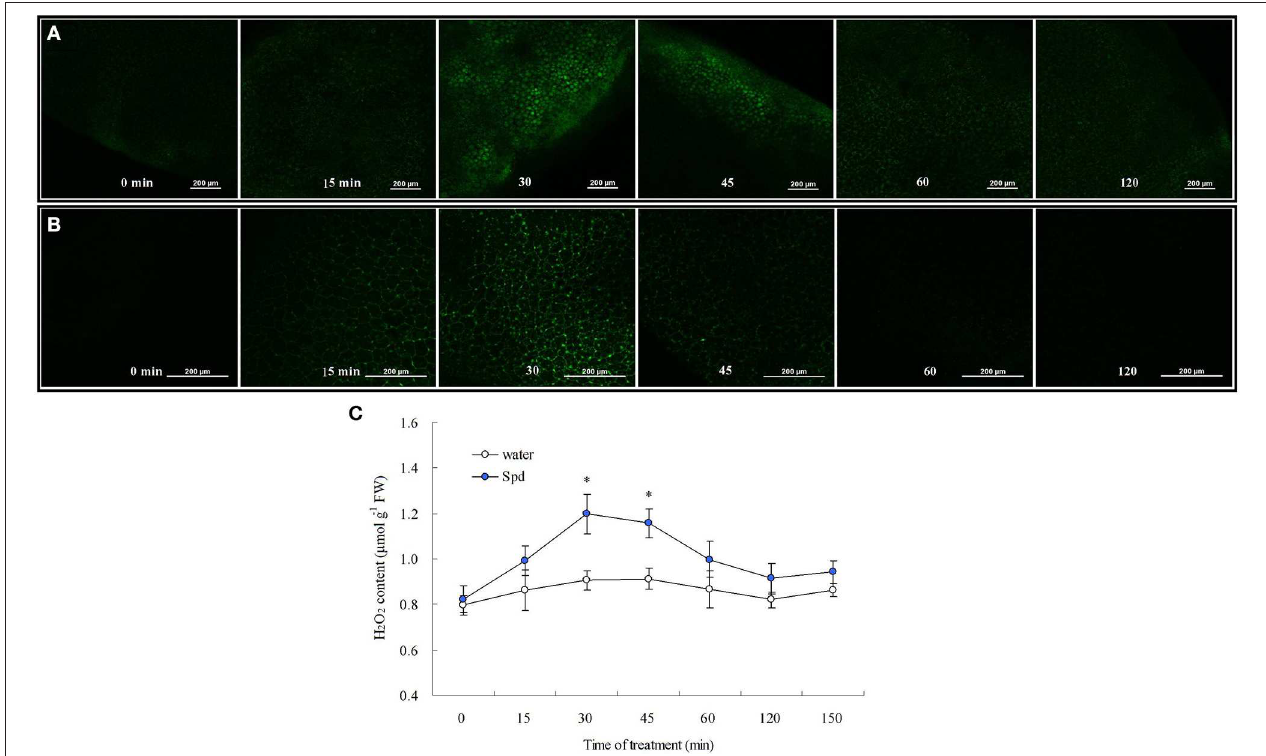
FIGURE 5 | Cytosolic free Ca 2 + (A) and H 2 O 2 production (B,C) as affected by spermidine (Spd) at different times. The detached leaves were pre-treated with distilled water for 1h to eliminate wound stress and then exposed to 20 µ M Spd for various time, followed by incubation with Ca 2 + -sensitive fluorescent probe Fluo-3-AM or H 2 O 2 -sensitive fluorescent probe H 2 DCFDA for 30min. Images are visualized using confocal laser scanning microscopy (CLSM). Means of four independent samples are presented. Bars represent standard error. “ * ” indicate LSD values where significant differences were detected ( P < 0.05) between two treatments at a given